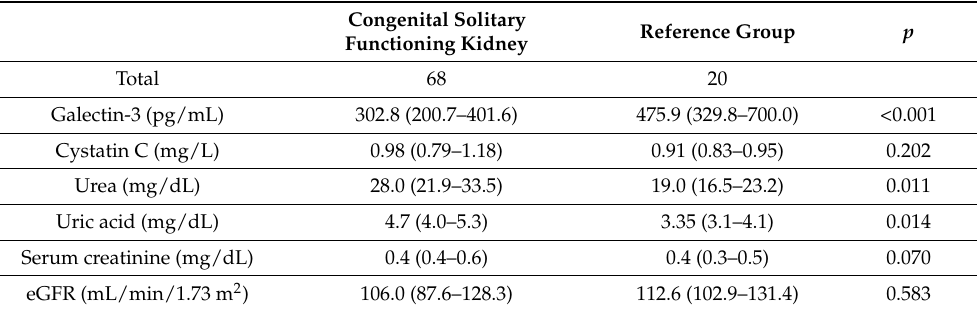
Table 2. Summary of the biochemical parameters in children with a congenital solitary functioning kidney and the reference group.